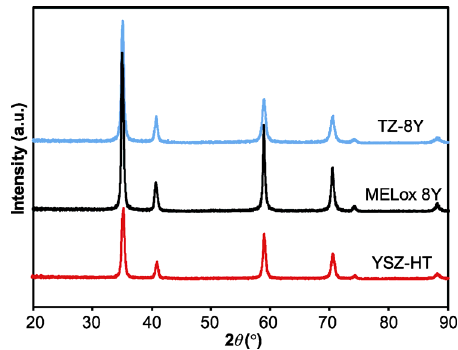
Fig. 3 XRD peaks for the YSZ powders.